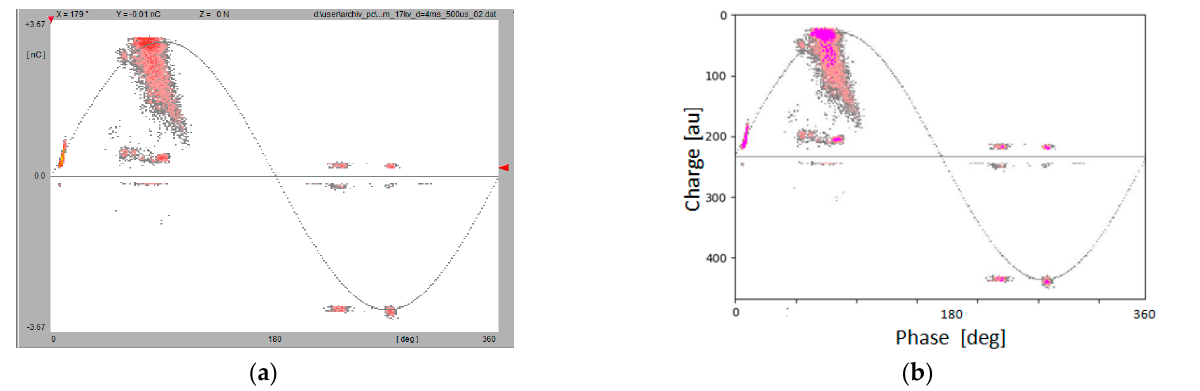
Figure 9. Identification of streamer hot spots during PD imaging experiment: ( a ) PD image; ( b ) K-means-highlighted clusters.